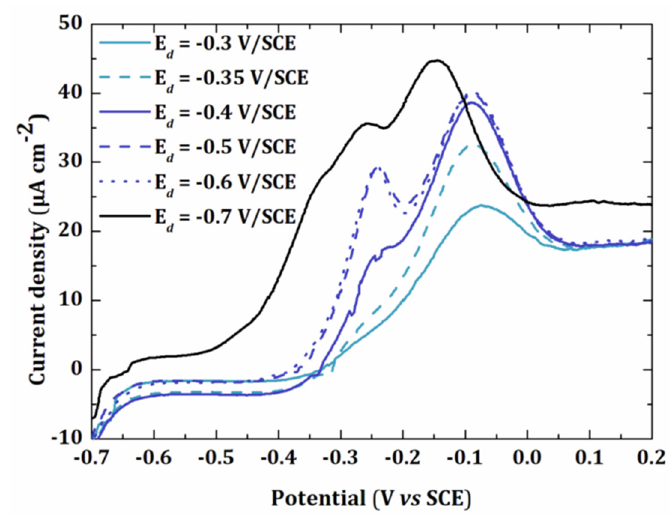
Figure 3. Linear sweep voltammetry of a 5 × 10 − 6 mol L − 1 solution of Pb(NO 3 ) 2 in 0.01 mol L − 1 KNO 3 at gold electrode (0.002 cm²) for a deposition time of 60 s at different deposition potentials ( (cid:3398) ) UPD1, ( (cid:3398) )UPD1 + UPD2, ( (cid:3398) ) UPD1 + UPD2 + multilayer.